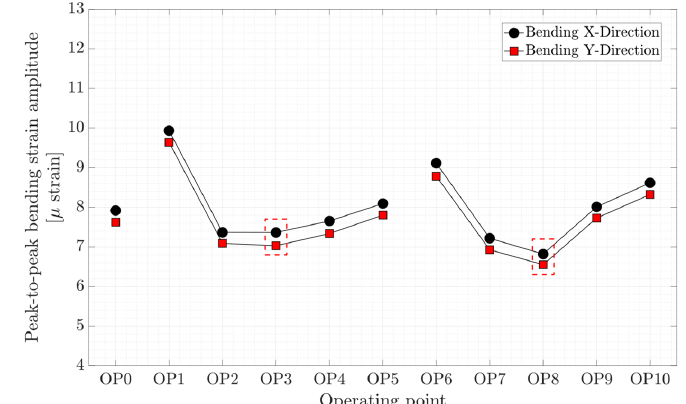
Figure 13. Peak-to-peak amplitude of torsion strain obtained on the shaft at OP0–OP10; red dashed-line boxes indicate the on-cam operating points.